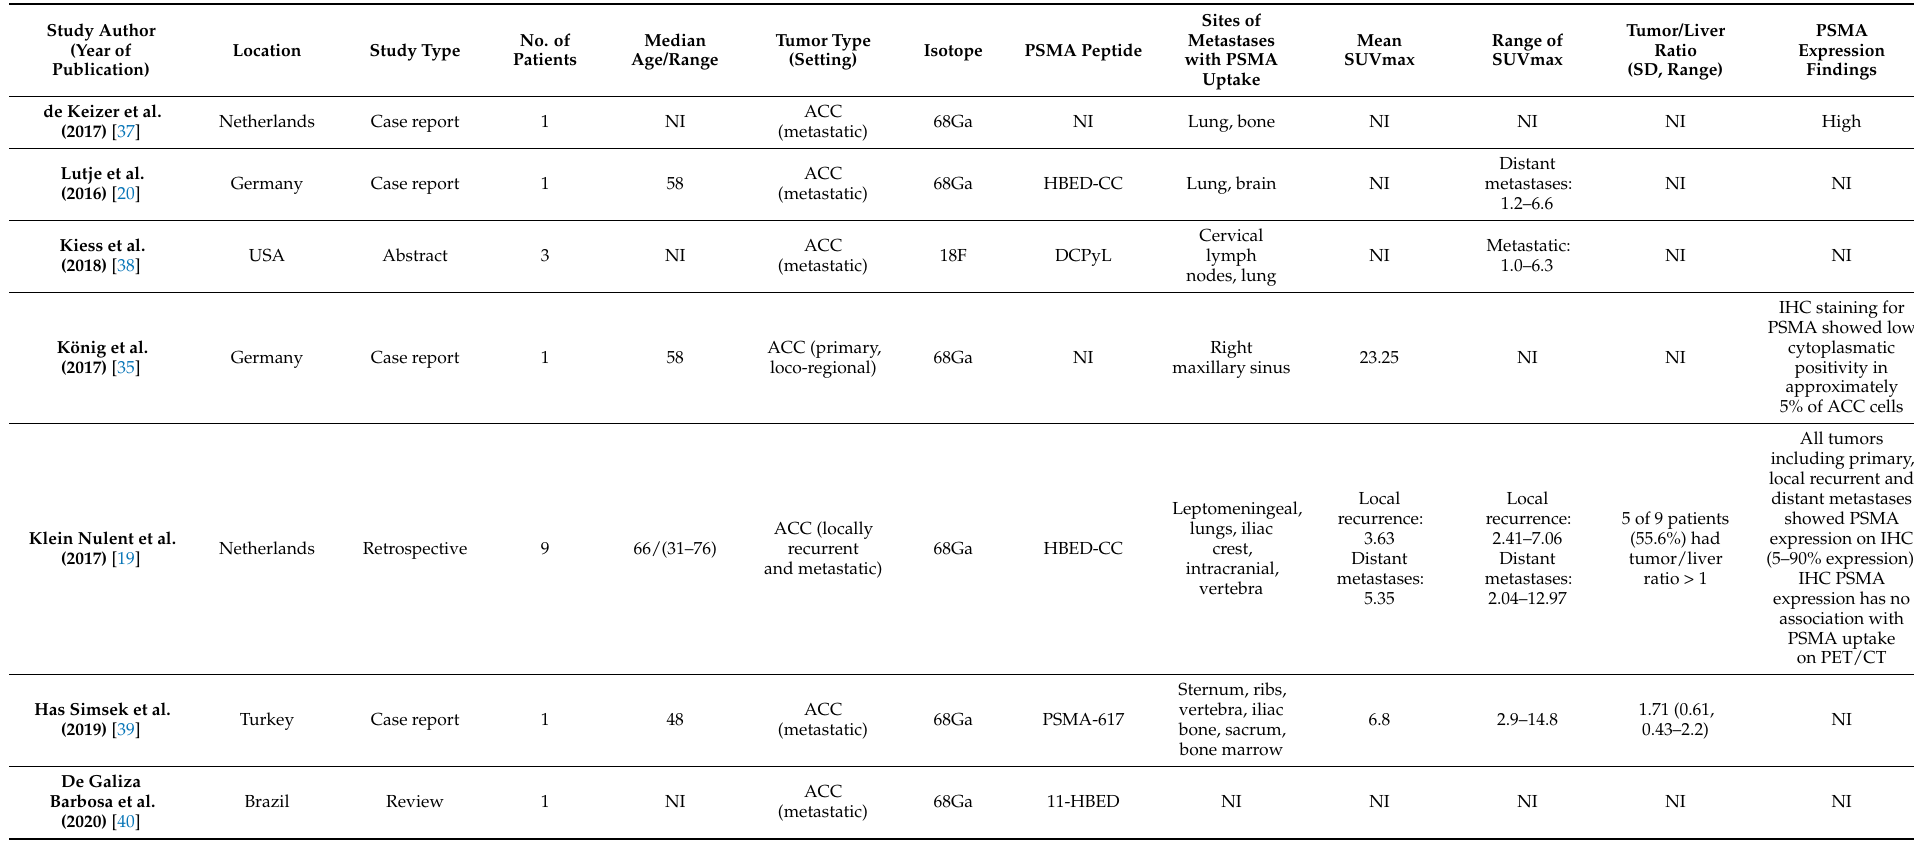
Table 1. Characteristics of